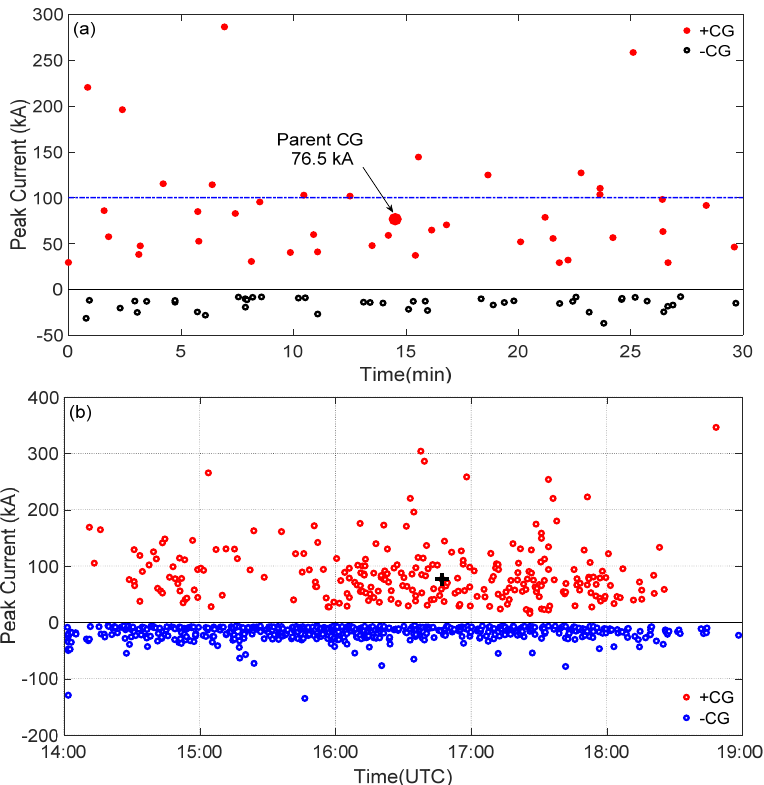
Figure 9. ( a ) The return stroke peak currents (within 50 km centered at the parent CG location) of CG lightning flashes within half an hour centered at the sprite. The red dots and black circles indicate positive and negative return strokes, respectively, and also mark the parent CG, with a peak current of 76.5 kA. ( b ) Peak current of CG flashes in the parent thunderstorm from 14:00 to 19:00. The black "+" is the parent CG of the sprite, and the red circle and blue circle represent the positive strokes and negative strokes, respectively.